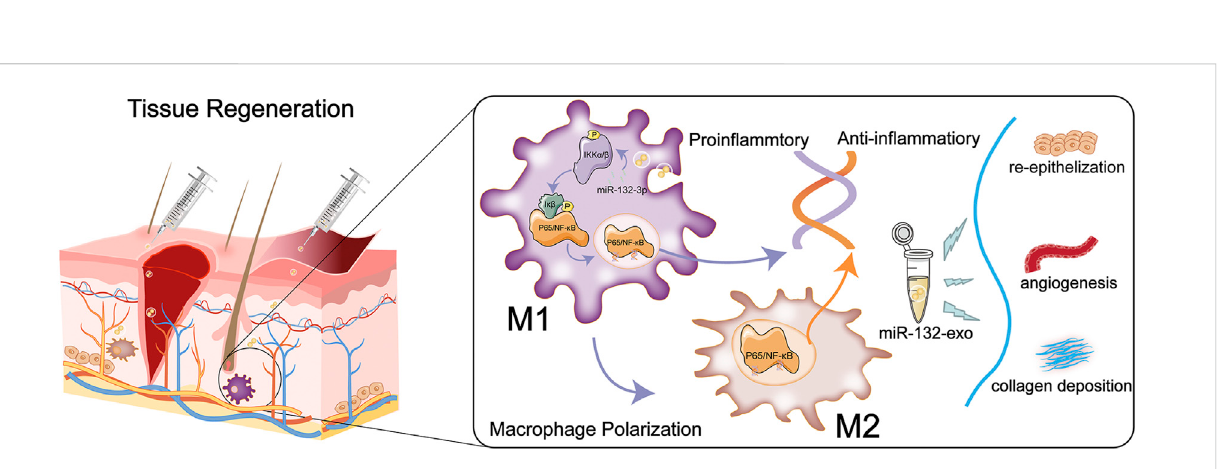
FIGURE 12 Schematic diagram of the function of miR-132-exo in wound repair and skin reconstruction and its possible mechanism.